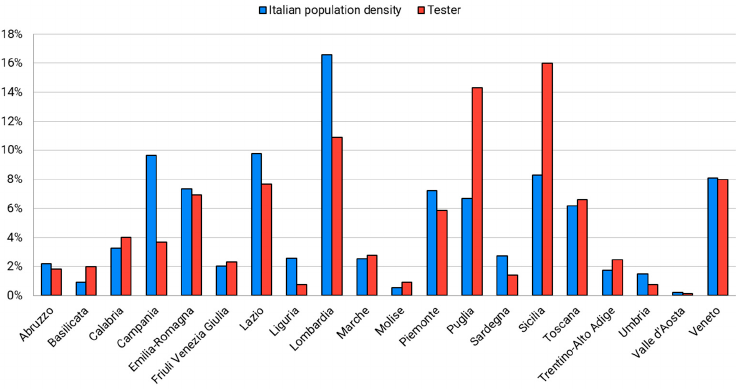
Figure 5. Comparison by region between population density and survey participants.